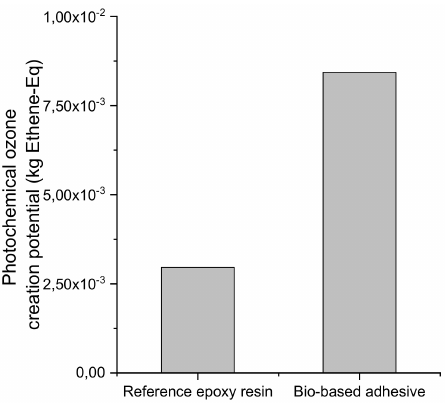
Figure 5. Comparison of POCP in terms of equivalent amount of C 2 H 4